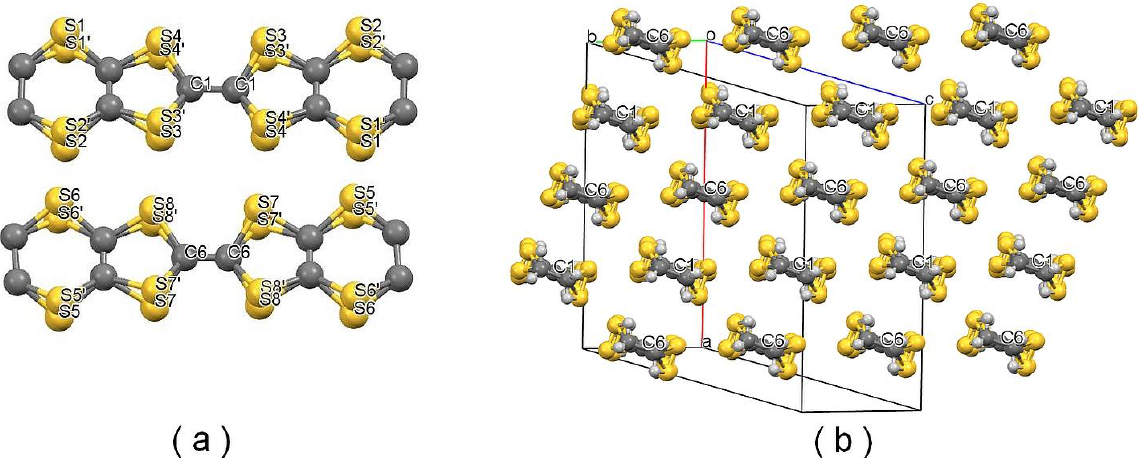
Figure 3. ( a ) The molecular structure of the radical cation part of 1 . The radical cations are disordered in two positions. In one of the positions, sulfur atoms are designated as S. In another position, they are designated as S ′ . ( b ) View of radical cation layer I along the direction of the central C=C double bond of the BEDT-TTF molecule.